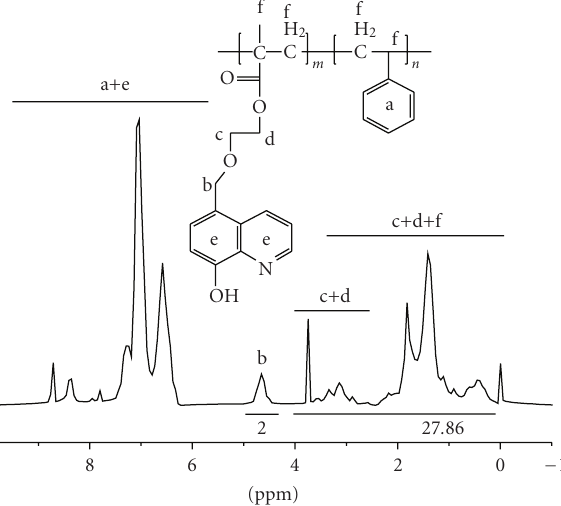
Figure 6: The 1 H NMR spectrum of random copolymer of HQHEMA and St (poly(HQHEMA- co -St)) in CDCl 3